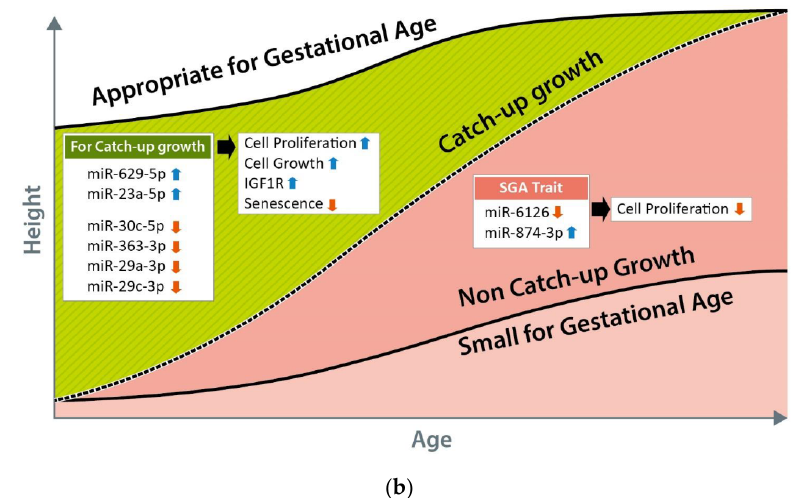
Figure 6. Candidate miRNAs involved in catch-up growth in SGA children. ( a ) These miRNAs are presumed to be involved in catch-up growth though regulation of cell proliferation, cell growth, IGF1 receptor and aging process. ( b ) Change in height and associated miRNAs with catch-up growth in SGA-CU and SGA-nCU children.